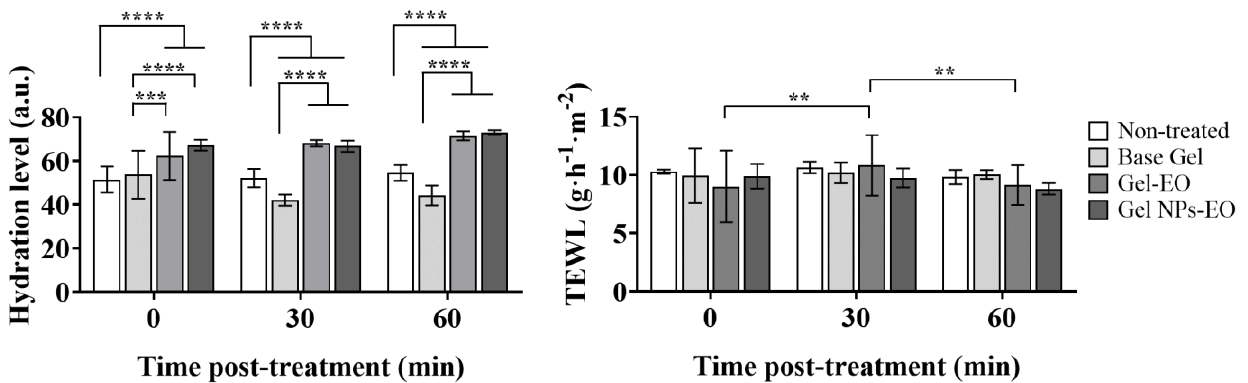
Figure 5. Effect of gel formulations (non-treated), Base Gel, gel containing free EO (Gel-EO) and gel containing EO loaded-NPs (Gel NPs-EO)) on hydration (arbitrary units; a.u.) and transepithelial water loss (TEWL, g·h −1 ·m −2 ) levels at 0, 30 and 60 min post-application in a delimited area of the volunteers’ forearm skin. Three volunteers participated in the study. Results are shown as the means ± SDs of 5 measurements for each treatment and at every time point under study, ** p < 0.01, *** p < 0.001, **** p < 0.0001.